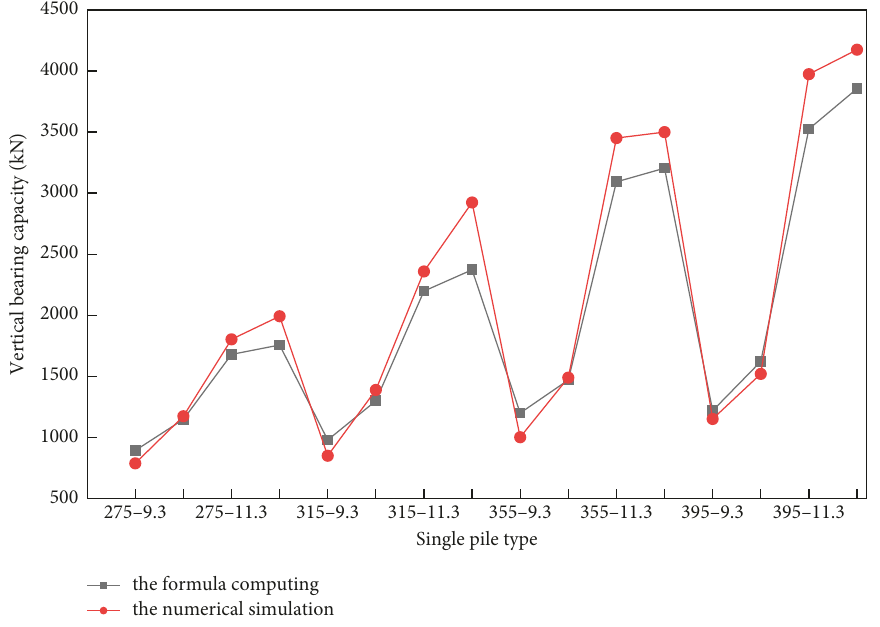
Figure 5: Comparison diagram of vertical bearing capacity of single